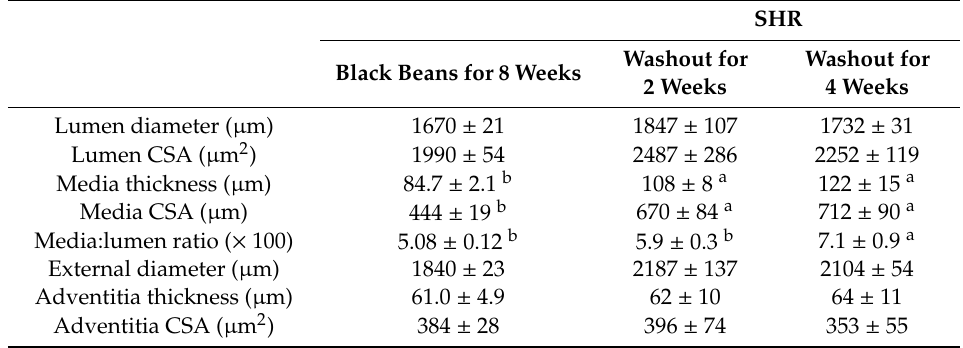
Table 7. Phase 2: Large-artery geometry 1 .